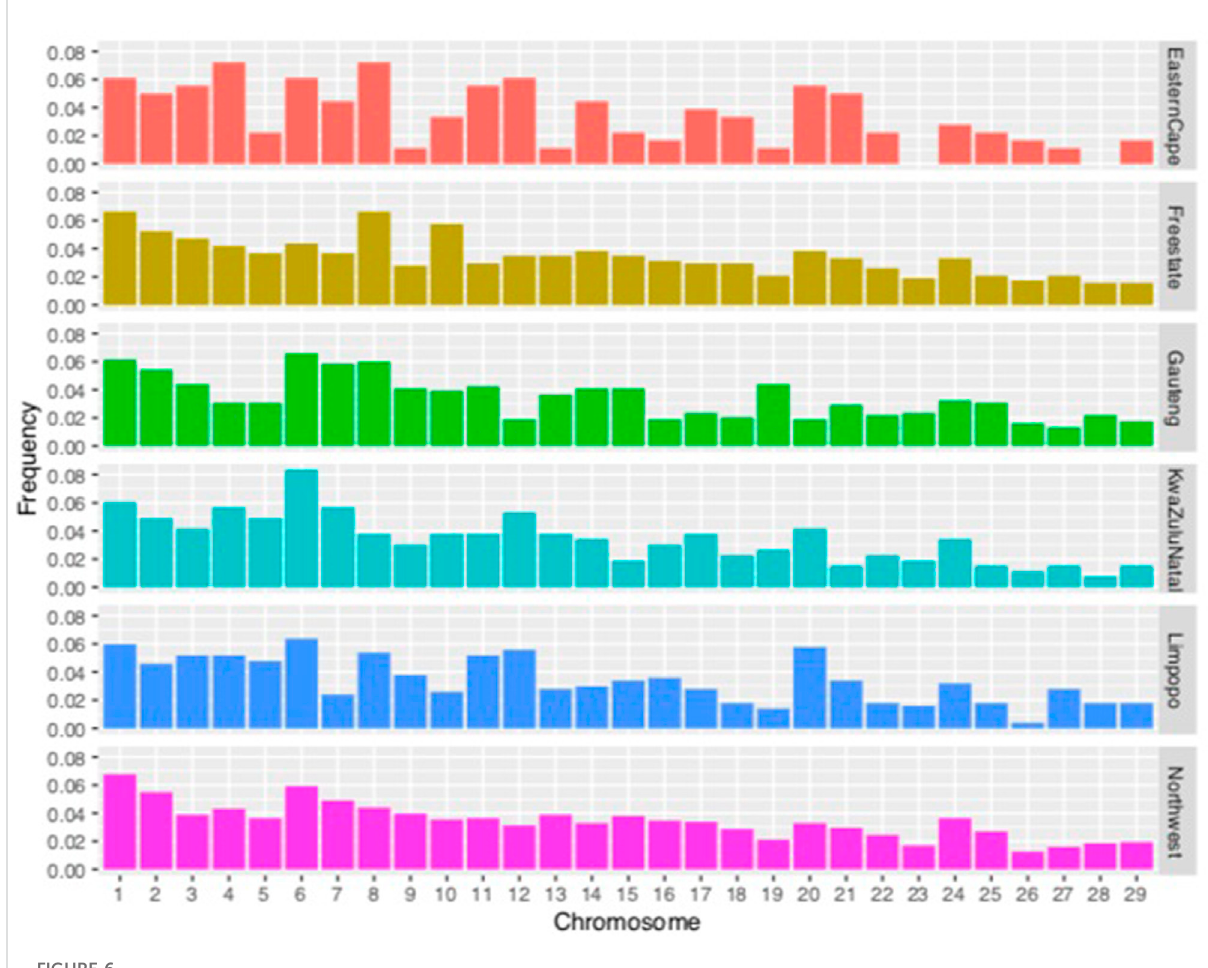
FIGURE 6 Frequency of runs of homozygosity (ROH) per chromosome per